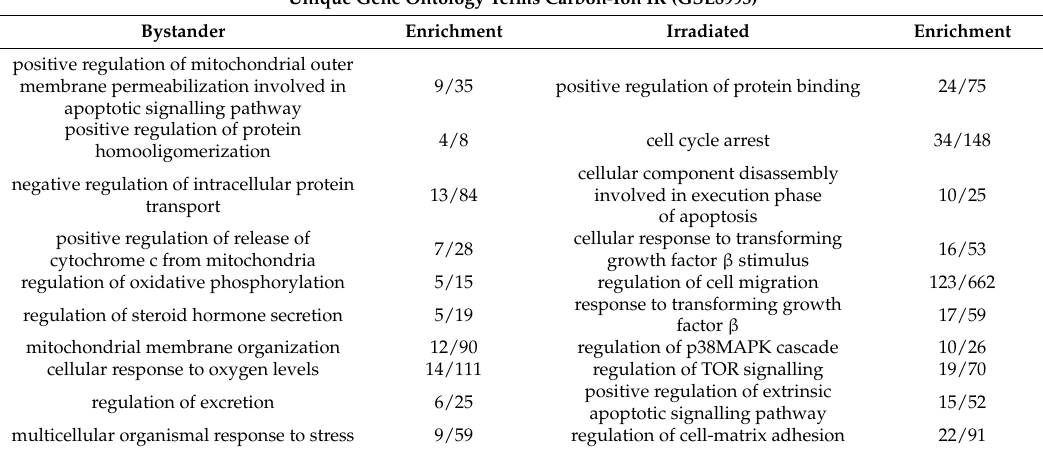
Table 6. Evaluation of differences in Gene Ontology terms resulting from functional enrichment analysis of datasets GSE8993 from unique DE genes between comparisons of bystander vs. control and irradiated vs. control samples.